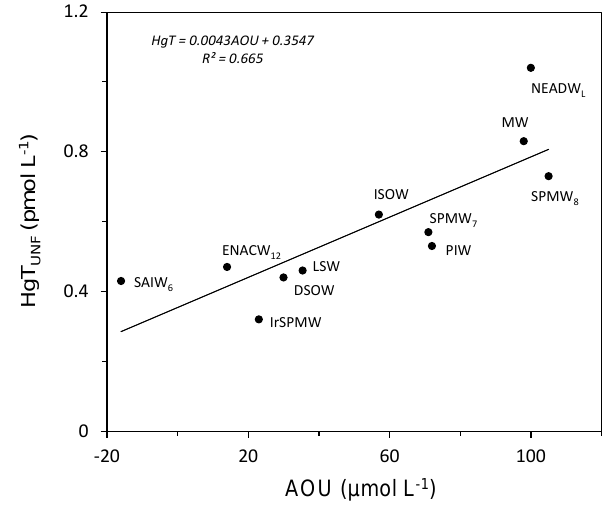
Figure 5. Total Hg in unfiltered samples (HgT UNF ) vs. apparent oxygen utilization (AOU) within the various source water